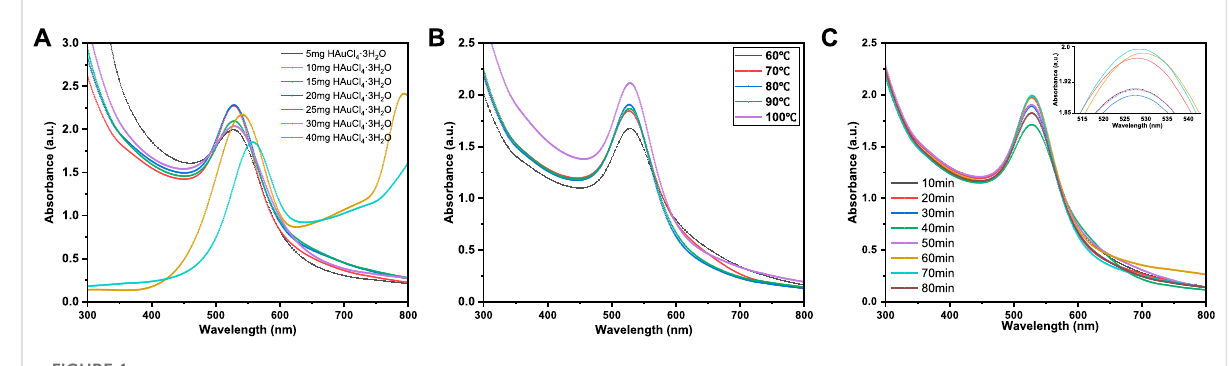
FIGURE 1 UV-vis spectra of xylan/Au NPs dispersions at (A) different reactant ratios (0.12 g Xylan: 5 – 40 mg HAuCl 4 · 3H 2 O), (B) different reaction temperature and (C) different reaction